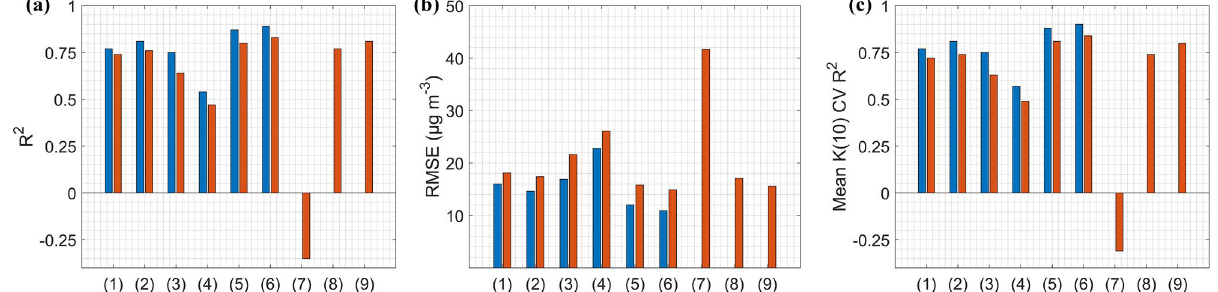
Figure 2. Performance comparison of different ML simulation types with 5375 days (blue) and 689 days (red) for training and testing. X axis indexes refer to the index of different ML simulation type (Table